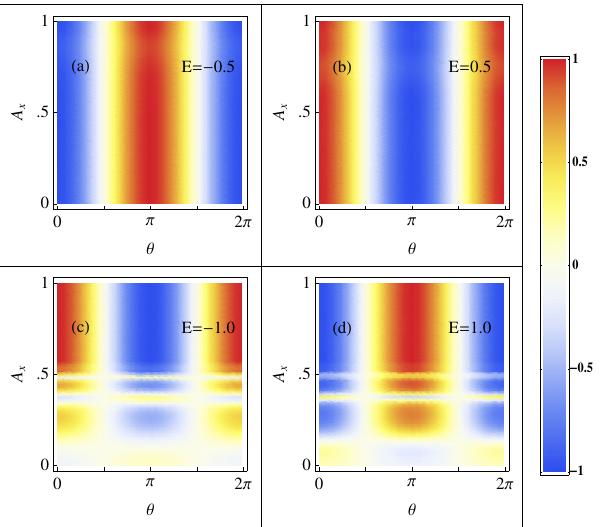
Figure 5. Simultaneous variation (density plot) of P with θ ( θ i = θ ∀ i ) and A x at some specific values of energy. The AAH phase φ ν =